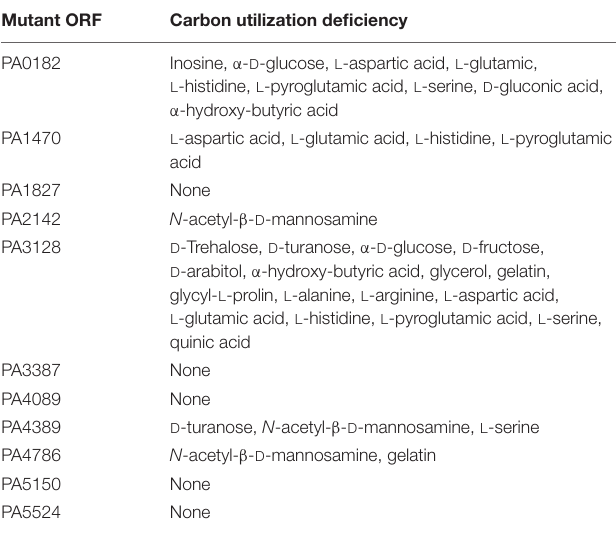
TABLE 3 | Carbon utilization by P. aeruginosa OAR - homolog-mutant strains. Mutant ORF Carbon utilization deficiency PA0182